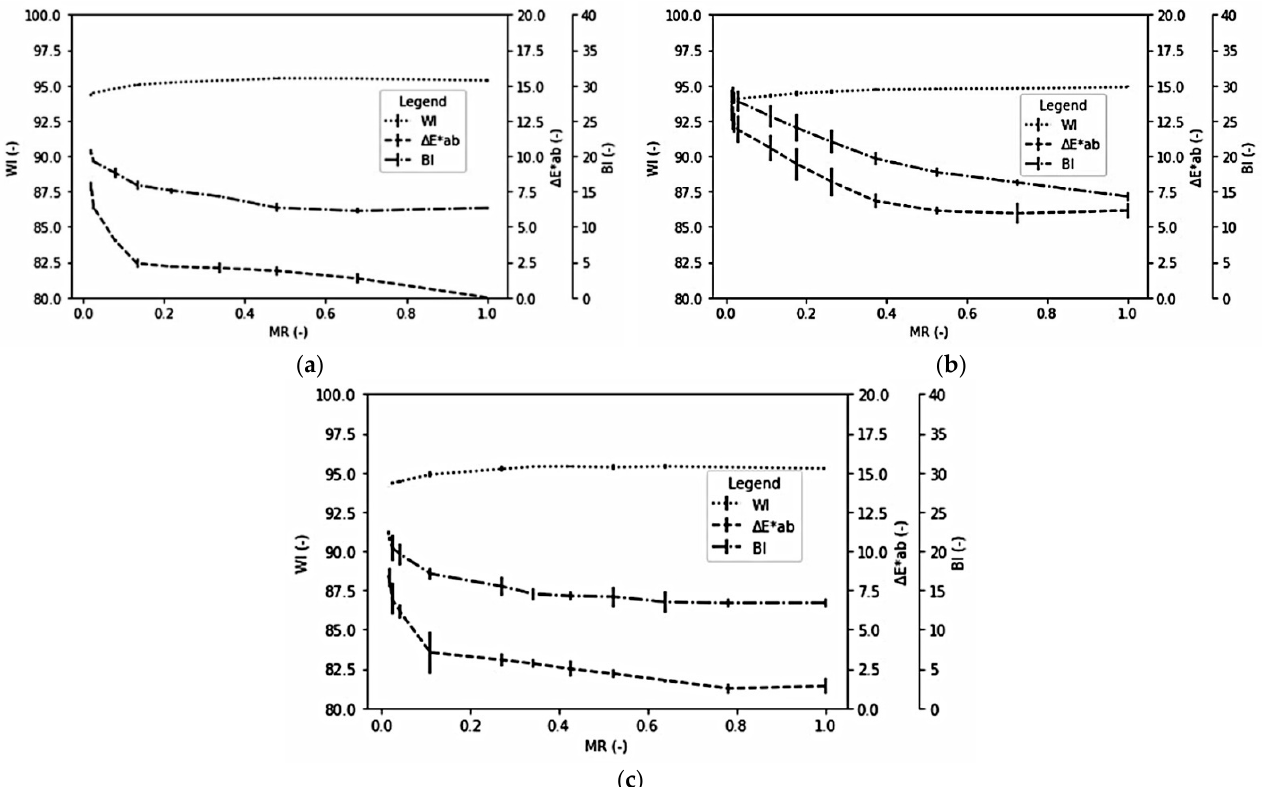
Figure 5. Dynamic changes of chromaticity indices as a function of MR at 60 °C drying temperature at ( a ) 2.9 m/s air velocity, 5 mm sample thickness, no pre-drying treatment; ( b ) 2.2 m/s air velocity, 5 mm sample thickness, blanching pre-drying treatment; ( c ) 2.2 m/s air velocity, 7 mm sample thickness, acid pre-drying treatment.